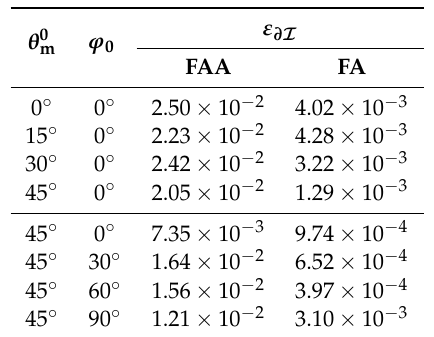
Figure 7. Partial derivatives ∂ I / ∂σ ext p at the base grid points ( x = p ∆ x , y = y 0 for different values of the solar azimuthal angle ϕ 0 . The results correspond to the detector zenith angle θ 0 m = 45 ◦ and are computed with the linearized forward-adjoint approach (FAA), the linearized forward approach (FA), and the finite-difference approach (FDA). Table 2. The first part of the table shows the relative errors ε ∂ I in the partial derivatives ∂ I / ∂σ ext p at the base grid points ( x = x 0 t , y = y 0 t , z = p ∆ z ), p = 1,...,11, for different values of the detector zenith angle θ 0 m , while the second part shows the relative errors ε ∂ I in the partial derivatives ∂ I / ∂σ ext p at the base grid points ( x = p ∆ x , y = y 0 t , z = L z /2), p = 1,...,19, for different values of the solar azimuthal angle ϕ 0 . The results are computed with the linearized forward-adjoint approach (FAA) and the linearized forward approach